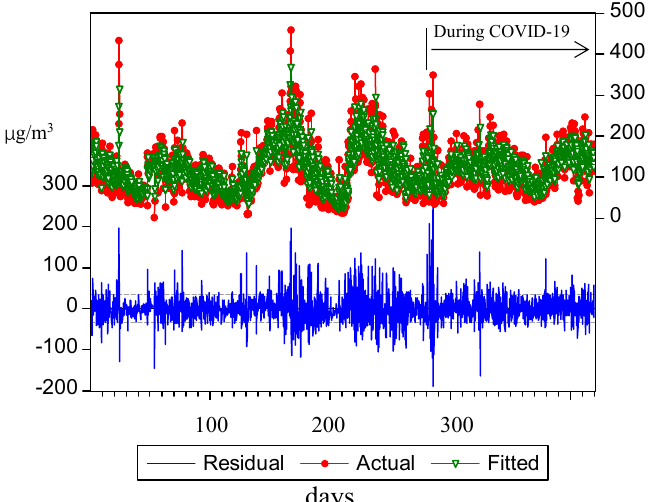
Figure 2. Estimation of the concentration of PM 10 with the VARMA (1,1)-EGARCH (1,1) model.